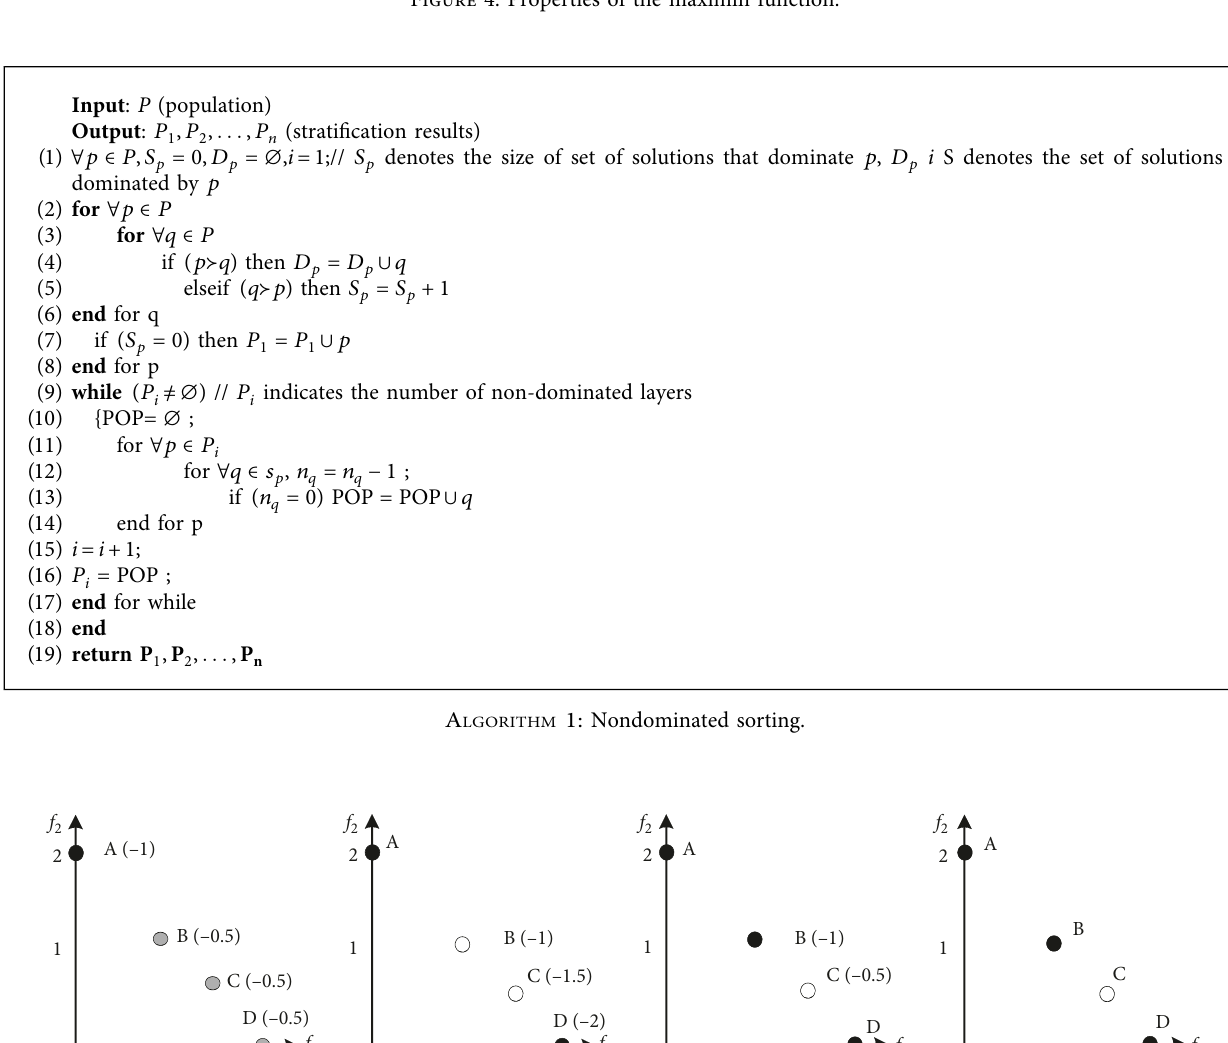
Figure 4: Properties of the maximin function.